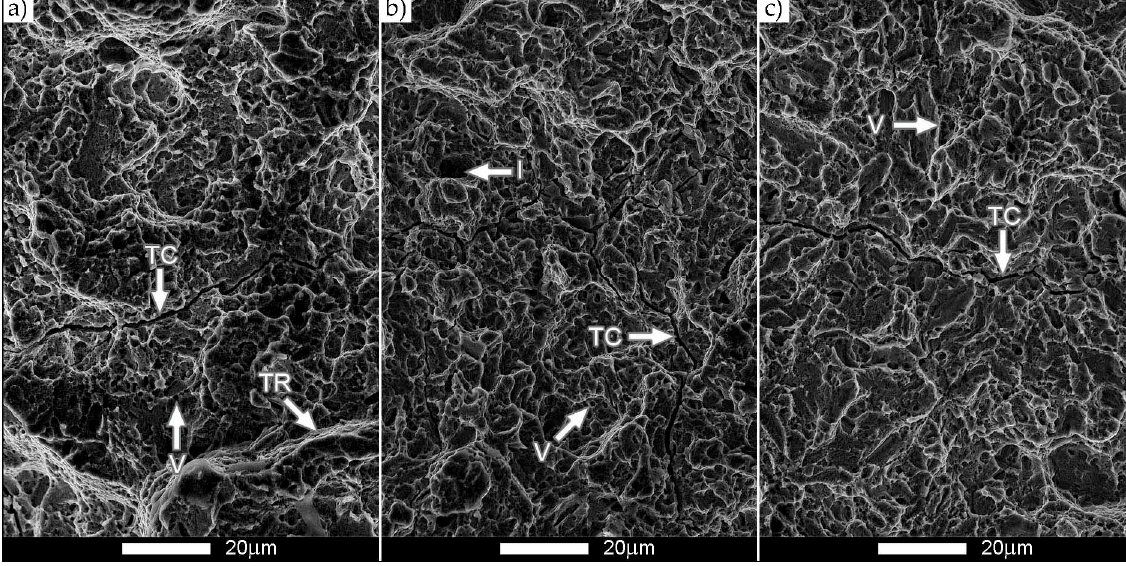
Figure 13. Images of the Hardox Extreme steel fracture surface in delivery state shown in Figure 9: transverse orientation (+20 °C). ( a ) The area marked with the A1 frame. ( b ) The area marked with the B1 frame. TR—tear ridges, V—microvoids, I—inclusions, voids left after debonded inclusions, TC—transversal cracks. ( c ) The area marked with the C1 frame. SEM, non-etched state.